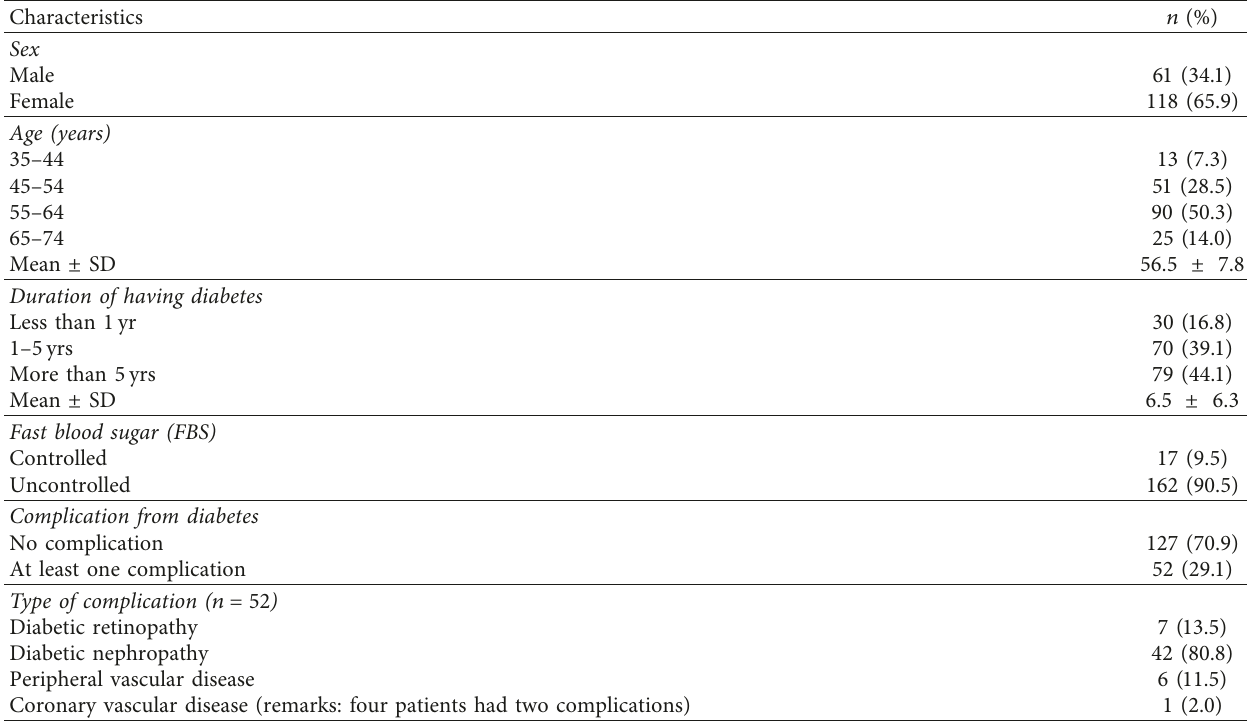
Table 1: Characteristics of the study population ( n � 179).